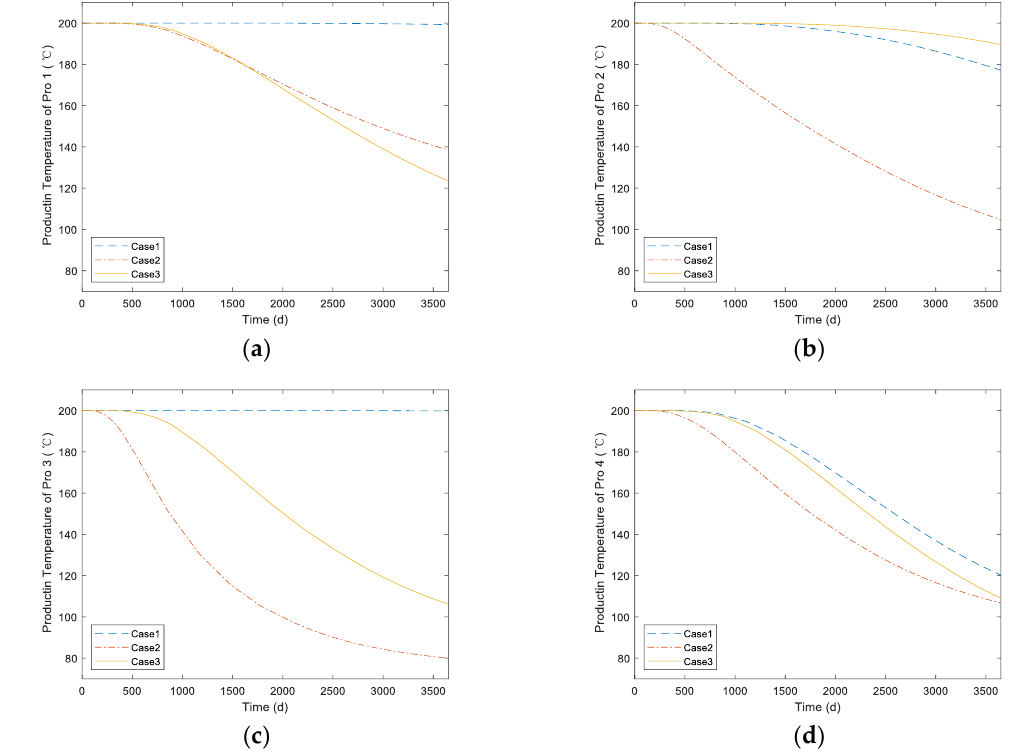
Figure 16. The average temperature of the production well ( a ) Pro1 ( b ) Pro2 ( c ) Pro3 ( d ) Pro4.